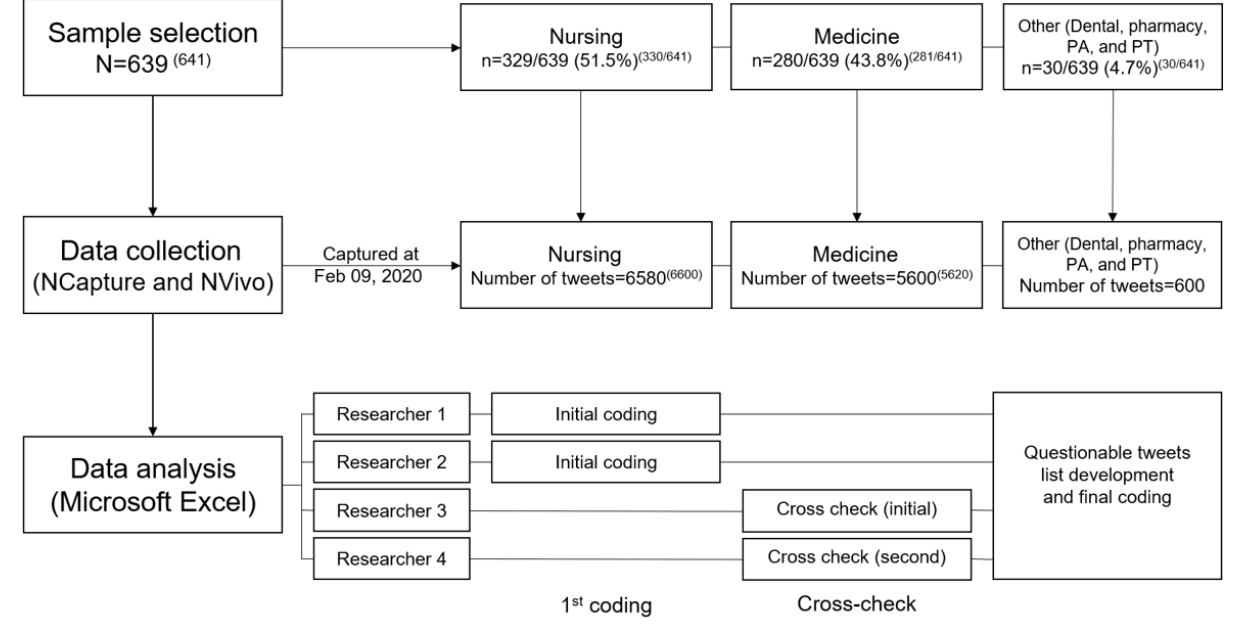
Figure 2. User account selection and data analysis process. PA: physician assistant; PT: physical therapy. Number of data used for analysis is provided within parenthesis in